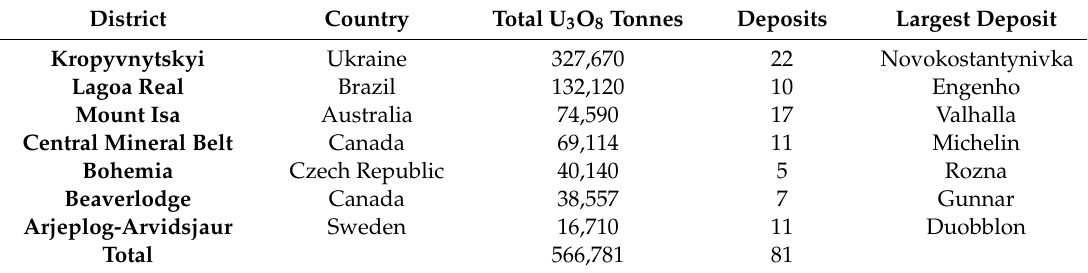
Table 1. Major shear-zone hosted uranium districts with approximate uranium endowment.